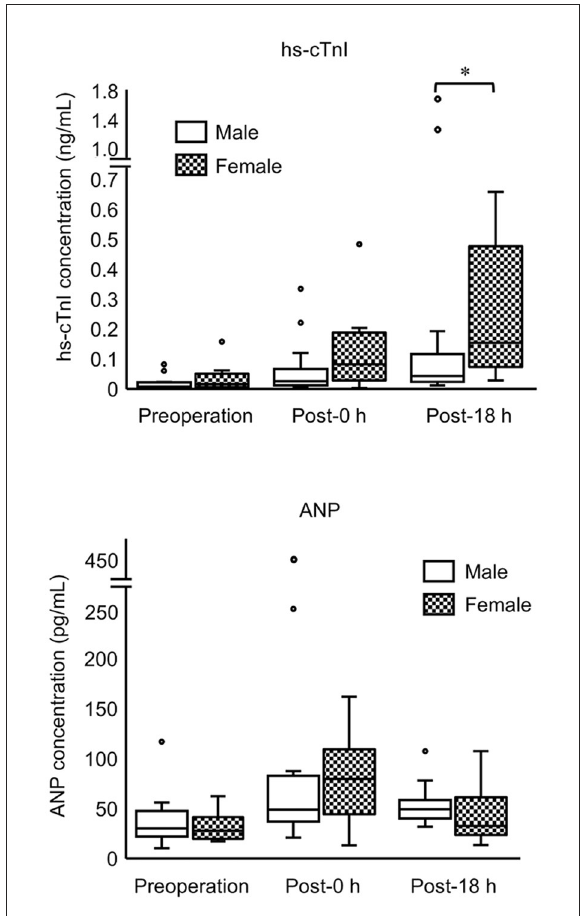
FIGURE2 Concentrations of hs-cTnI and ANP in male and female cats at three measurement points (preoperation, 0h postoperation, 18h postoperation). The top and bottom of the box represent the 75th and 25th percentiles, respectively; middle line, median; whiskers, highest and lowest data points within 1.5 times the length of the quartiles; and circles, outliers. Data of hs-cTnI and ANP are not normally distributed (non-parametric data). Asterisks indicate statistical difference (* P <